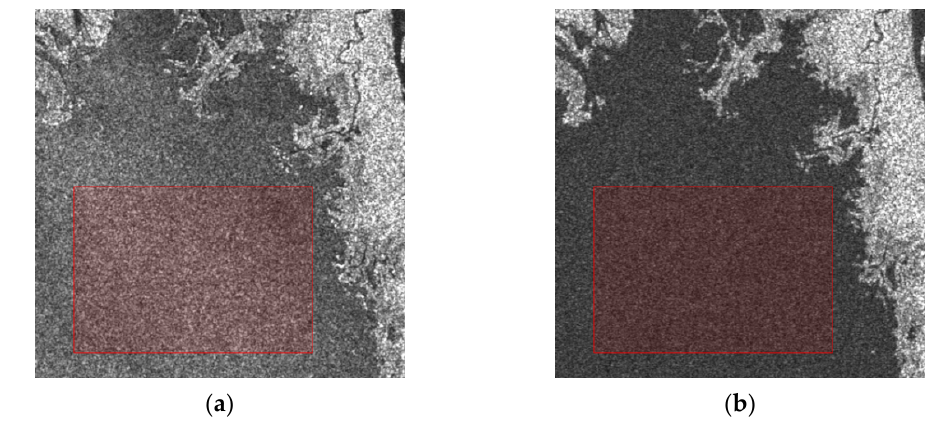
Figure 1. Here, 512 × 512 pixel fragments of Sentinel-1 SAR images with VV ( a ) and VH ( b ) polarizations with manually selected quasi-homogeneous regions marked by red squares.